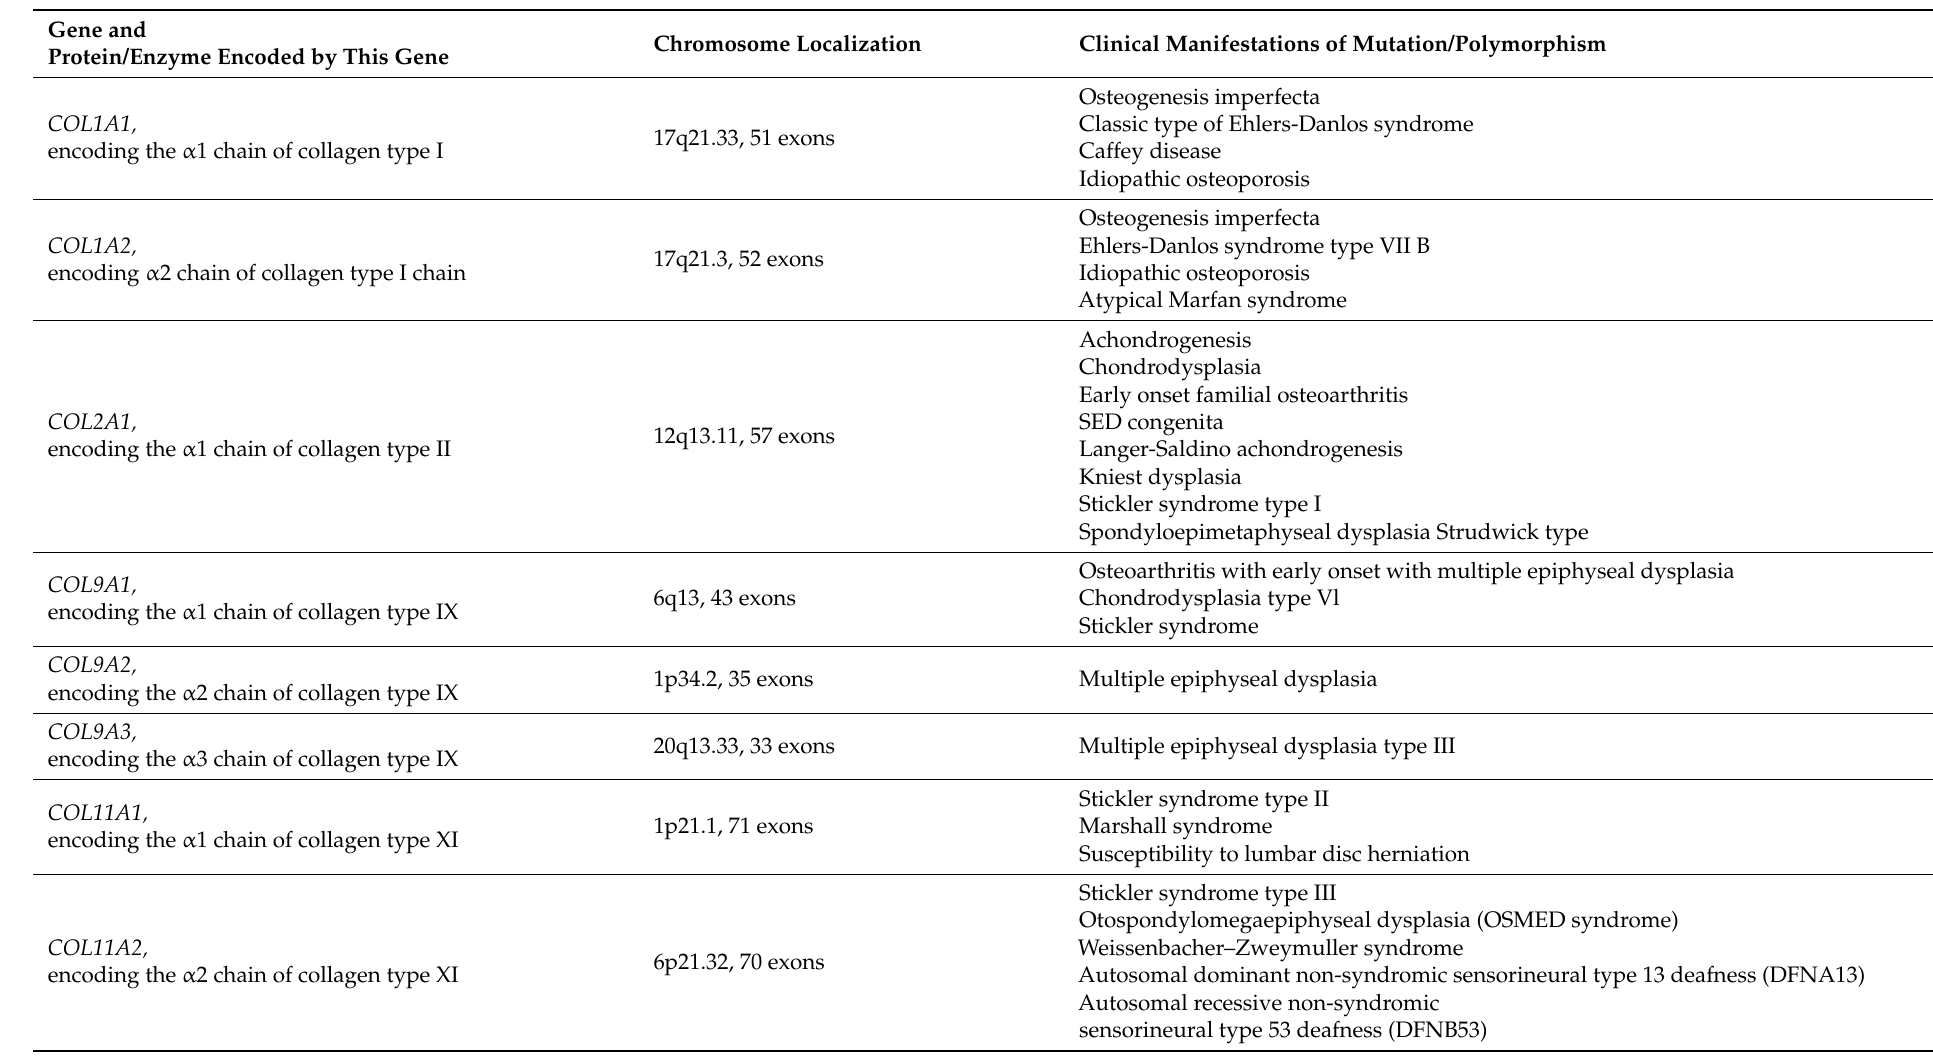
Table 1. Genes responsible for the structure of collagen fibers in intervertebral disk and diseases caused by their mutations